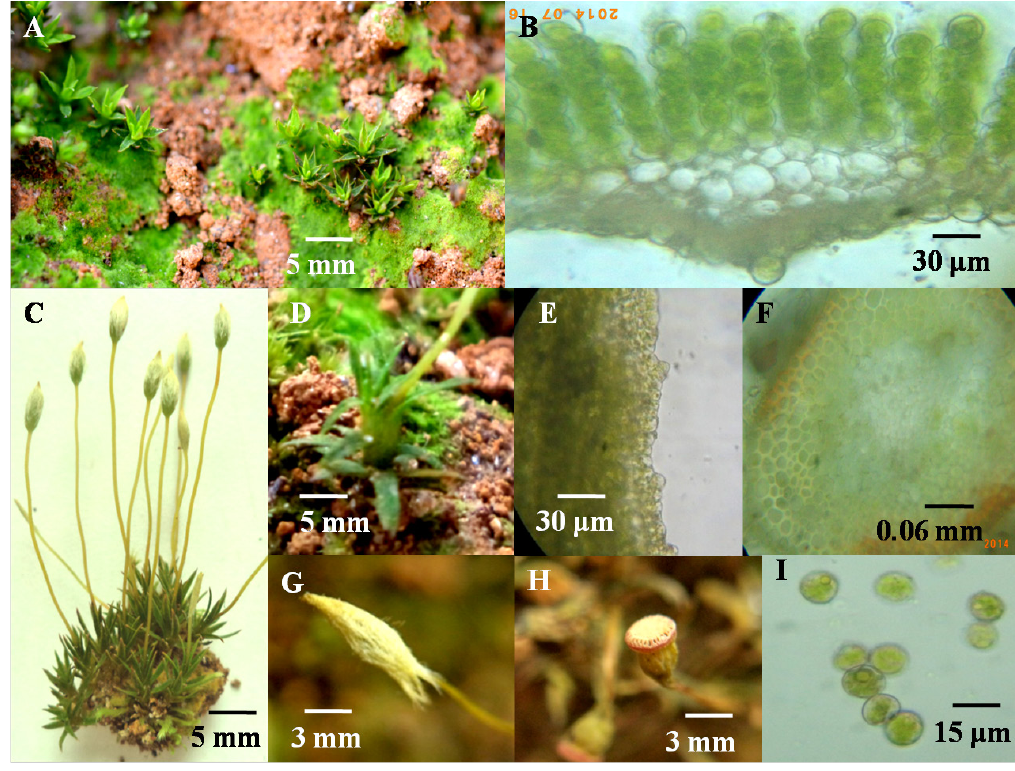
Figure 6: Pogonatum aloides (Hedw.) P. Beauv. (A) persistantprotonema, (B) transverse section of leaf (C) female gametophytes with sporophytes (D) female gametophyte (E) leaf margin (F) transverse section of stem, (G) calyptra, (H) capsule without lid (I)